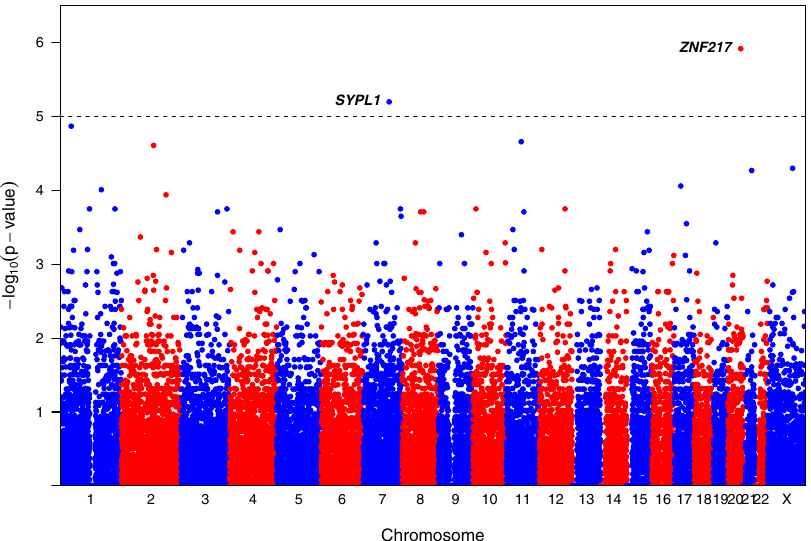
Fig. 2 Manhattan plot for a genome-wide somatic non-coding variant enrichment analysis in the Nigerian group. The dotted horizontal line represents the genome-wide signi fi cance threshold (pairwise Fisher ’ s exact test two-sided P -values adjusted by Benjamini – Hochberg FDR < 0.1) with two bins showing signi fi cant enrichment of somatic non-coding variants in two previously unreported breast cancer (Supplementary Fig. 11). The functional consequences of the identi fi ed non-coding mutations are yet to be established.